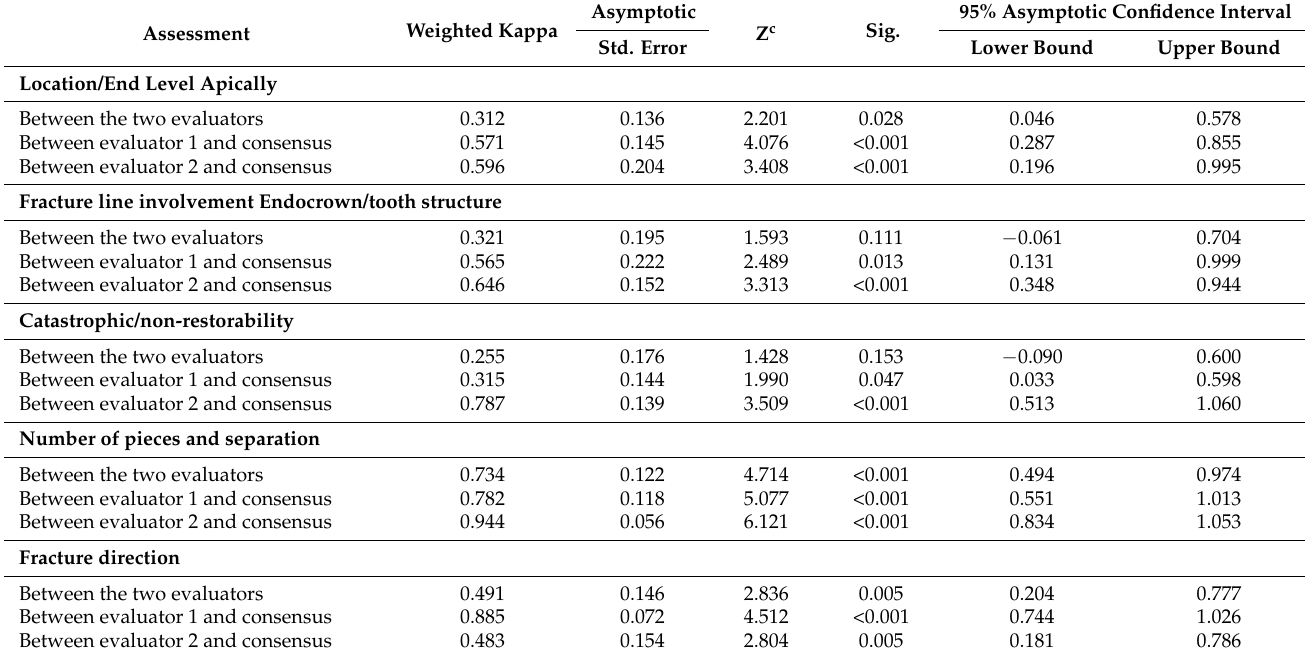
Table 2. Agreement between the two examiners and each one to the consensus for each assessment point using Kappa statistics.